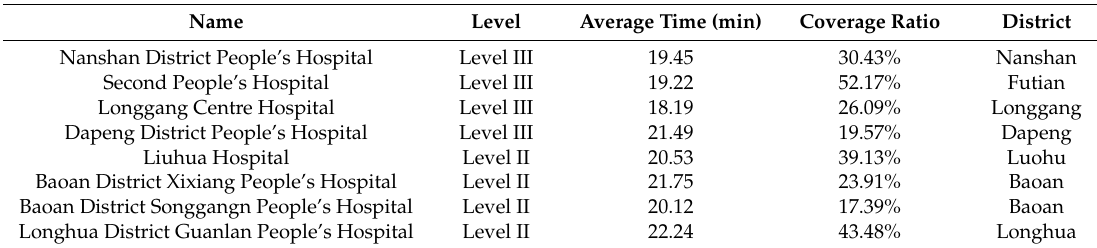
Table 5. Information about high-level trauma centers.